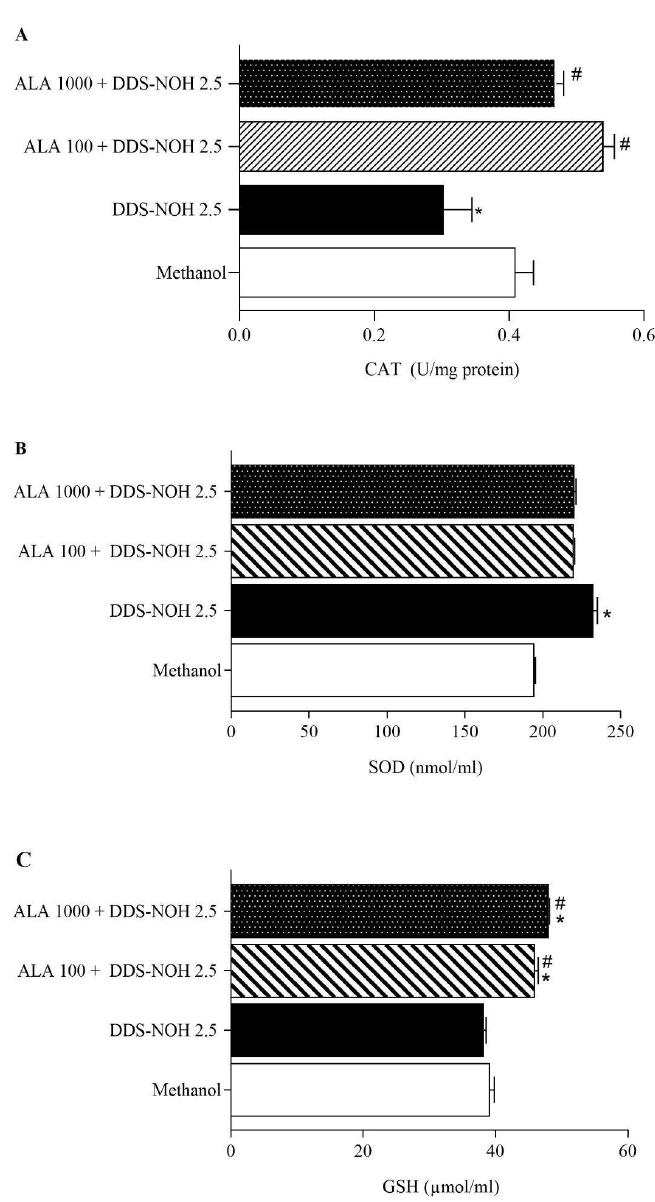
Figure 3. Effect of pretreatment with ALA on CAT and SOD activities and GSH production. ( A ) Catalase activity with different concentrations of ALA ( B ) SOD activity with different concentrations of ALA ( C ) Glutathione activity with different concentrations of ALA Erythrocytes were pretreated with ALA (100 and 1000 μ M) for 1 h at 37 °C and incubated for 30 min with DDS ‐ NOH (2.5 μ g/mL). Results are expressed as mean ± S.E.M. * p < 0.05 compared to methanol; # p < 0.05 compared to the DDS ‐ NOH group.